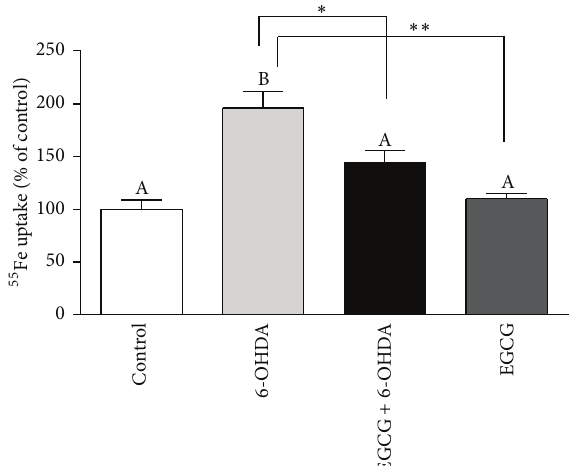
Figure 4: 55 Fe iron uptake by the N27 cell. Cells were treated with EGCG (100 𝜇 M) for 2 h followed by 6-OHDA (25 𝜇 M) for 24 h. Percentage of 55 Fe uptake was calculated by measuring the fraction of radioactivity in the cell lysates in relation to initial added radioactivity. Values (mean ± SEM, 𝑛 = 3 ) are expressed as percentage of controls after normalizing with protein concentration. Bar means without a common letter differ. ∗ 𝑝 < 0.05 ; ∗∗ 𝑝 < 0.01